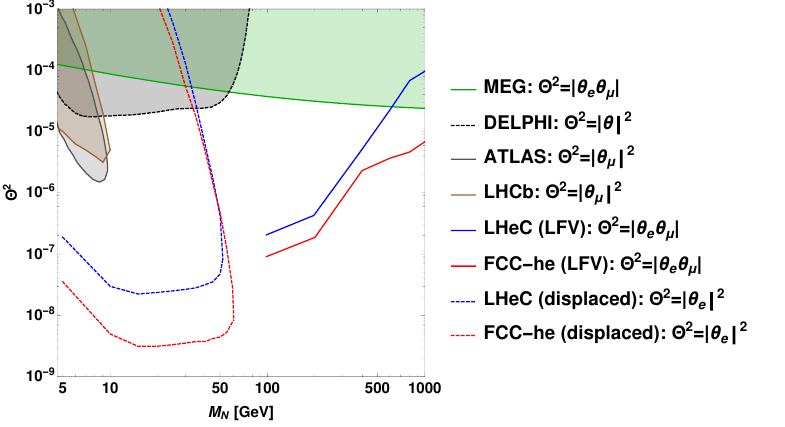
Figure 7 . Sensitivity of the LFV lepton-trijet searches (at 95% C.L.) and the displaced vertex searches (at 95% C.L.) compared to the current exclusion limits from ATLAS [6], LHCb [36], LEP [2], and MEG [37]. The sensitivity of the lepton-trijet searches at ep colliders can be generalized to its full (cid:18) (cid:11) -dependence by replacing j (cid:18) e (cid:18) (cid:22) j with 2 j (cid:18) e j 2 j (cid:18) (cid:22) j 2 = j (cid:18) j 2 . Notice that each experiment is sensitive to a di(cid:11)erent set of active-sterile mixing parameters, as indicated in the